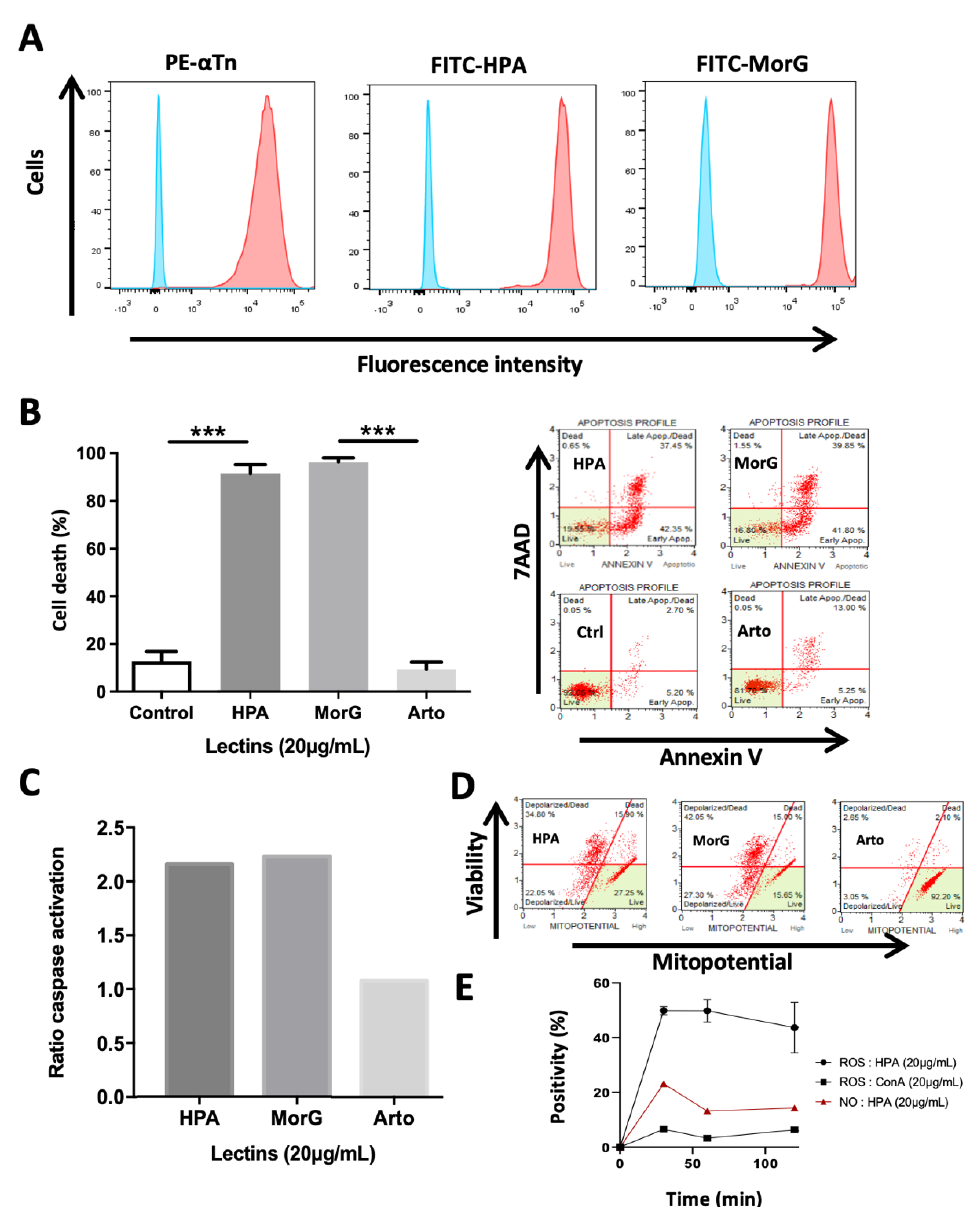
Figure 1. HPA induces cell death in human T-leukemia cells: ( A ) Jurkat A3 leukemia cells were labeled with anti-Tn mouse monoclonal antibody (PE- α Tn), FITC-conjugated HPA (FITC-HPA), or FITC-conjugated Morniga G (FITC-MorG), and analyzed using cytofluorimetry (blue curves indicate cell autofluorescence). ( B – D ) Leukemia cells were cultured for 48 h in the presence of 20 μ g/mL HPA, MorG, or Artocarpin (Arto), then analyzed by cytofluorimetry. ( B ) Specific cell death evaluated using Annexin V/7AAD assay, on the right: representative experiment; ( C ) caspase activation; and ( D ) mitochondrial depolarization, representative of two independent experiments. ( E ) Jurkat cells were cultured with 20 µ g/mL HPA or Concanavalin A (ConA). Next, reactive oxygen species (ROS) or nitric oxide (NO) were evaluated at different times using cyto-fluorimetry. ( B , C , E ), Results are means ± SD of at least three independent experiments or means of two independent experiments. Significant differences are indicated (*** p <